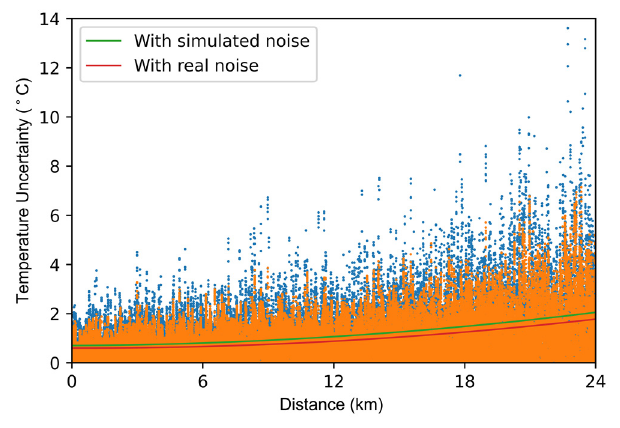
Figure 9. Distributed temperature uncertainty along fiber length.